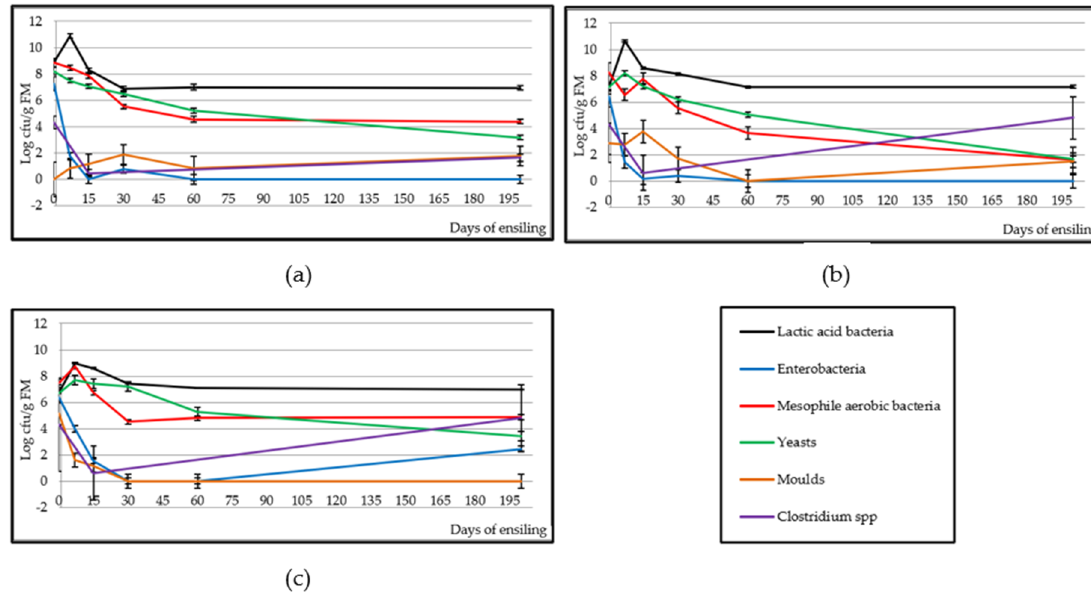
Figure 2. Effect of ensiling on microbial populations in broccoli by-product ( a ), artichoke by-product ( b ) and artichoke plant stubble ( c ) silages.